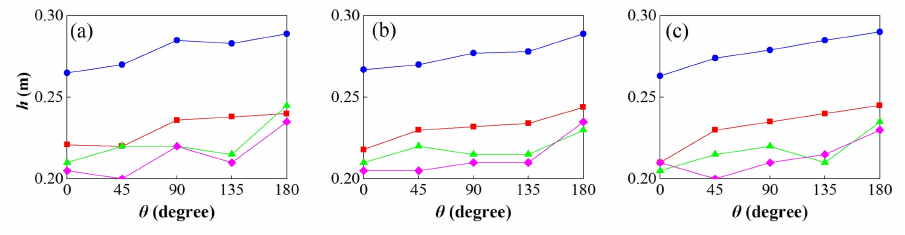
Figure 2. Water depth variations along the curved reach for four cases: ( a ) Q = 0.015 m 3 s − 1 , ( b ) Q = 0.025 m 3 s − 1 , and ( c ) Q = 0.030 m 3 s − 1 ( • Bare case; (cid:4)